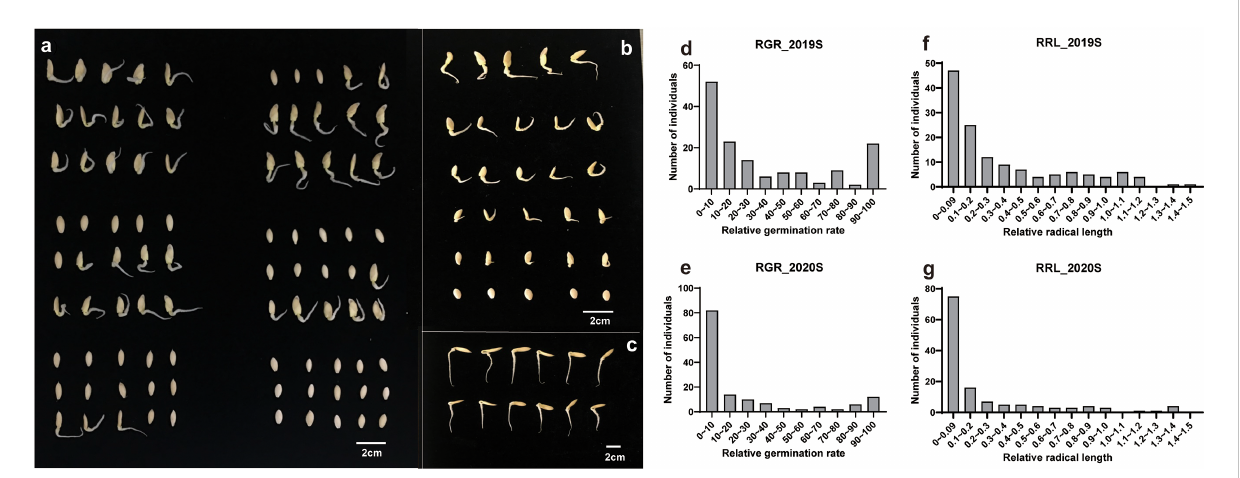
FIGURE 1 Differences in germination rate at low temperature stress among accessions from the core germplasm. (A) Germination rate and (B) radical lengths of accessions from the core germplasms incubated at 13°C. (C) Germination under control, i.e., 28°C, temperatures. Bars = 2 cm. (D, E) Relative germination rate and (F, G) relative radical length in 2019S and